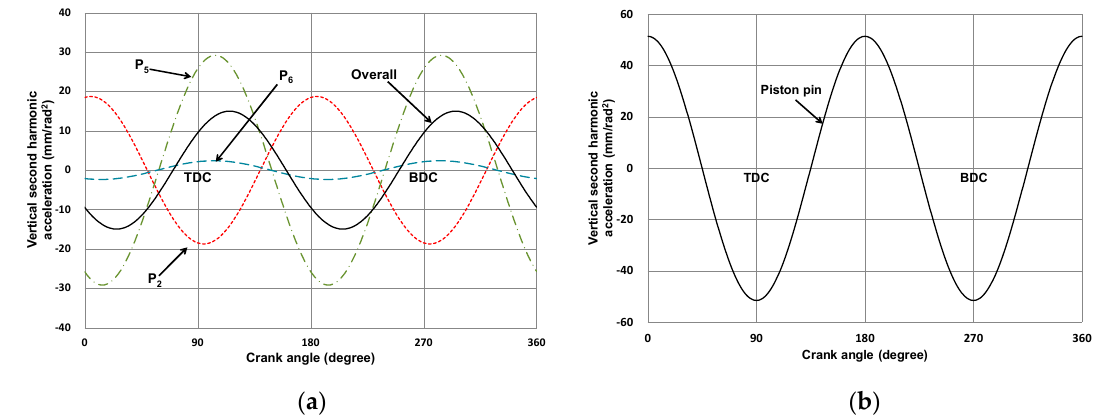
Figure 12. Vertical second harmonic acceleration components at each joint in four-cylinder engine: ( a ) final design of the Stephenson III mechanism and ( b ) the slider-crank mechanism.